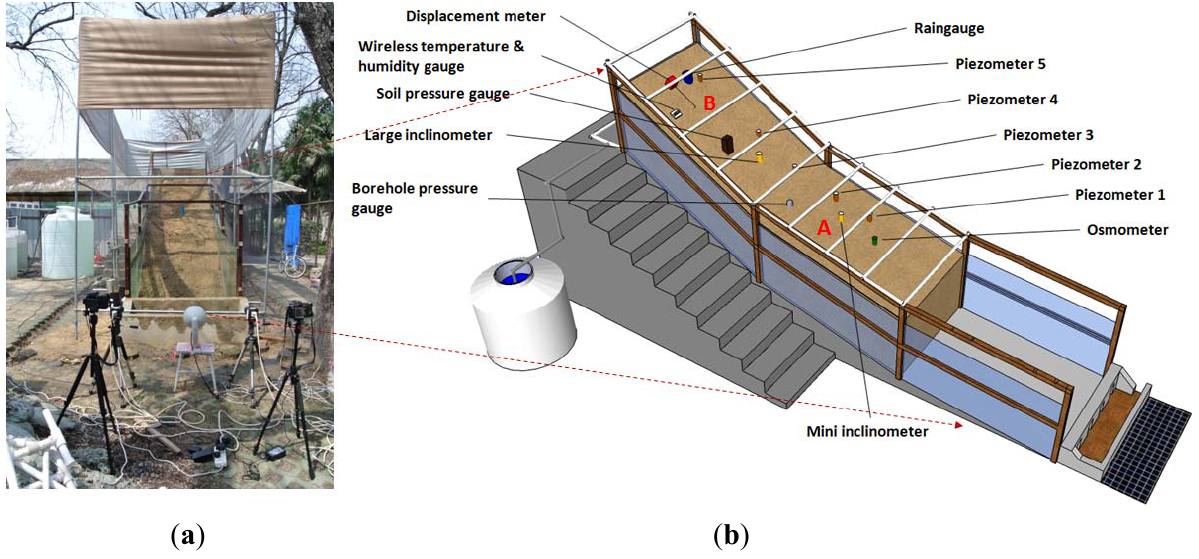
Figure 8. The scaled-down landslide simulation platform on the campus of Tongji University ( a ) and the spatial distribution of in situ sensors for the experiment ( b